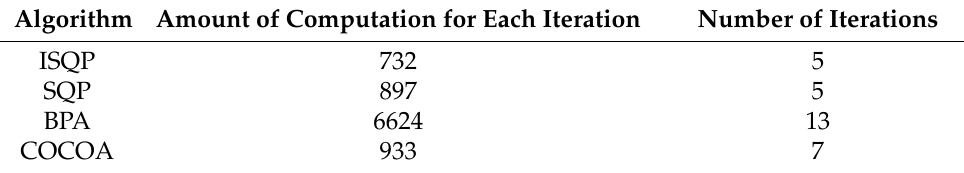
Table 8. Complexity Comparison for SISO under Perfect Channel Estimation.